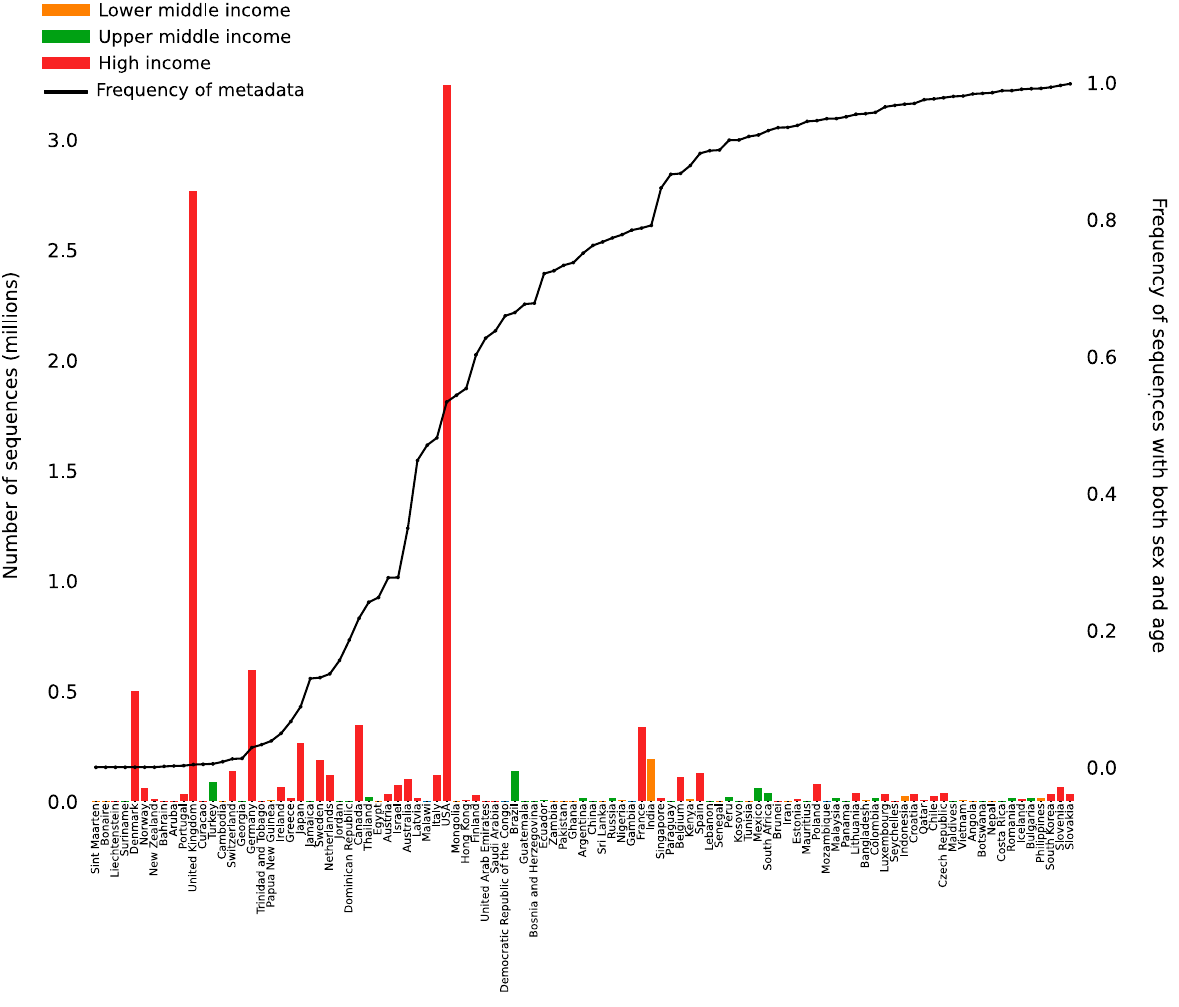
Figure 2. Sequence count and metadata prevalence by country. The number of SARS-CoV-2 whole- genome sequences available from each country in GISAID (accessed 5 September 2022) as colored bars. The colored bars represent the income level as defined by the Worldbank. The percentages of sequences with associated sex and age metadata are represented by the black line.